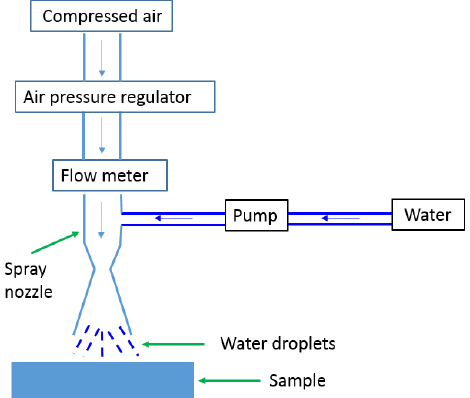
Figure 1. A schematic diagram of the water impinging test.